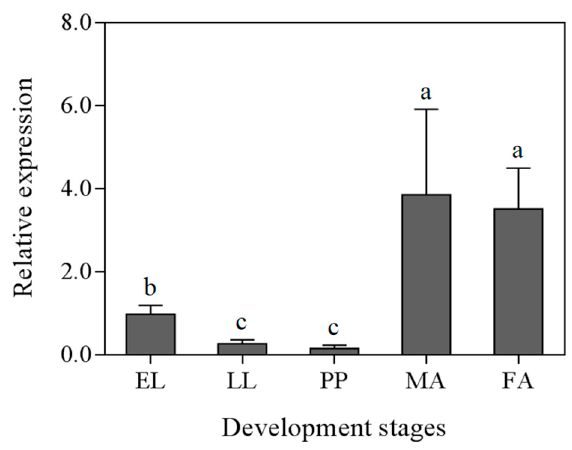
Figure 6. Expression profiles of MaCel1 in different developmental stages of M. alternatus . EL: early larvae; LL: late larvae; PP: pupae; MA: male adult; FA: female adult. The data in the graph were mean ± standard error, and the different letters on the column represent the significant difference in the relative expression in different developmental stages.